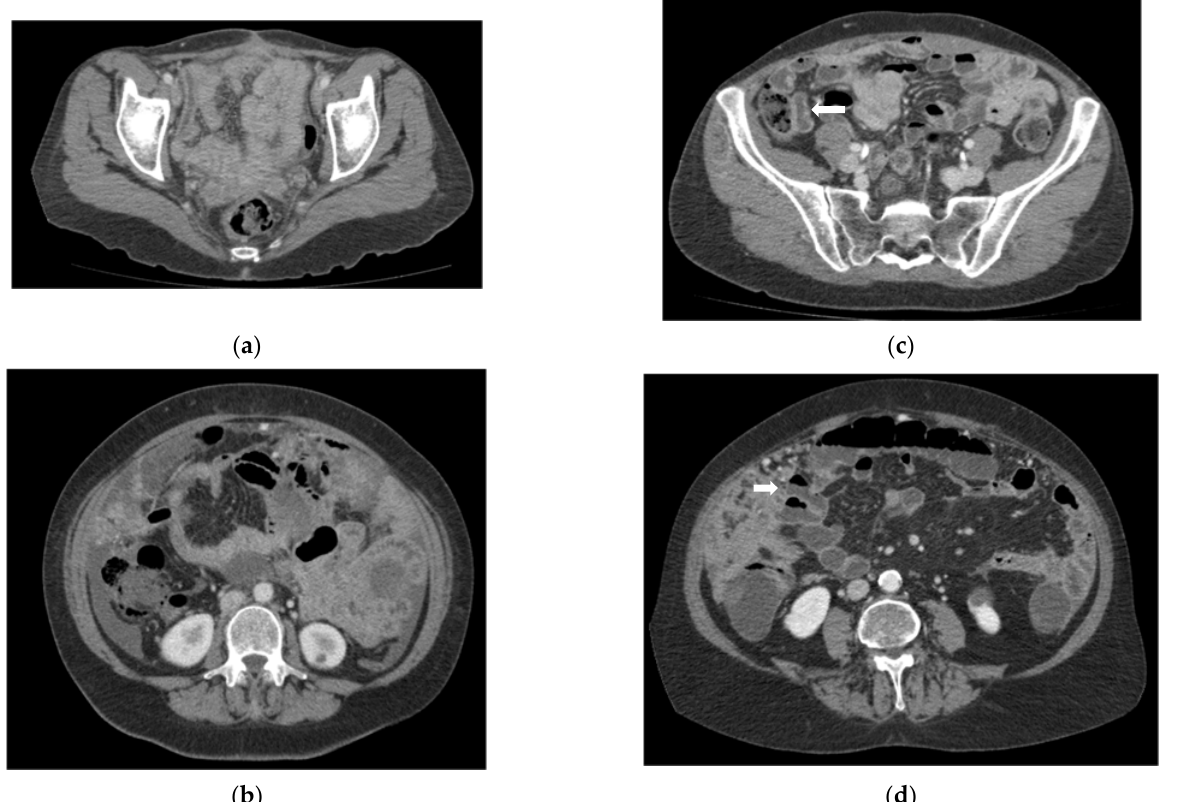
Figure 2. Axial slice images from different patients are shown to compare the degree of intestinal distention obtained by: ( a , b ) routine CT; ( c , d ) CT enterography section at the pelvis and mid abdomen of a patients with peritoneal carcinomatosis show the difference between the non-optimized and optimized imaging techniques, with the CTE an adequate distention of the intestinal loops is achieved. (rCT: routine CT, CTE: CT enterography), soft tissue nodules (arrowhead).